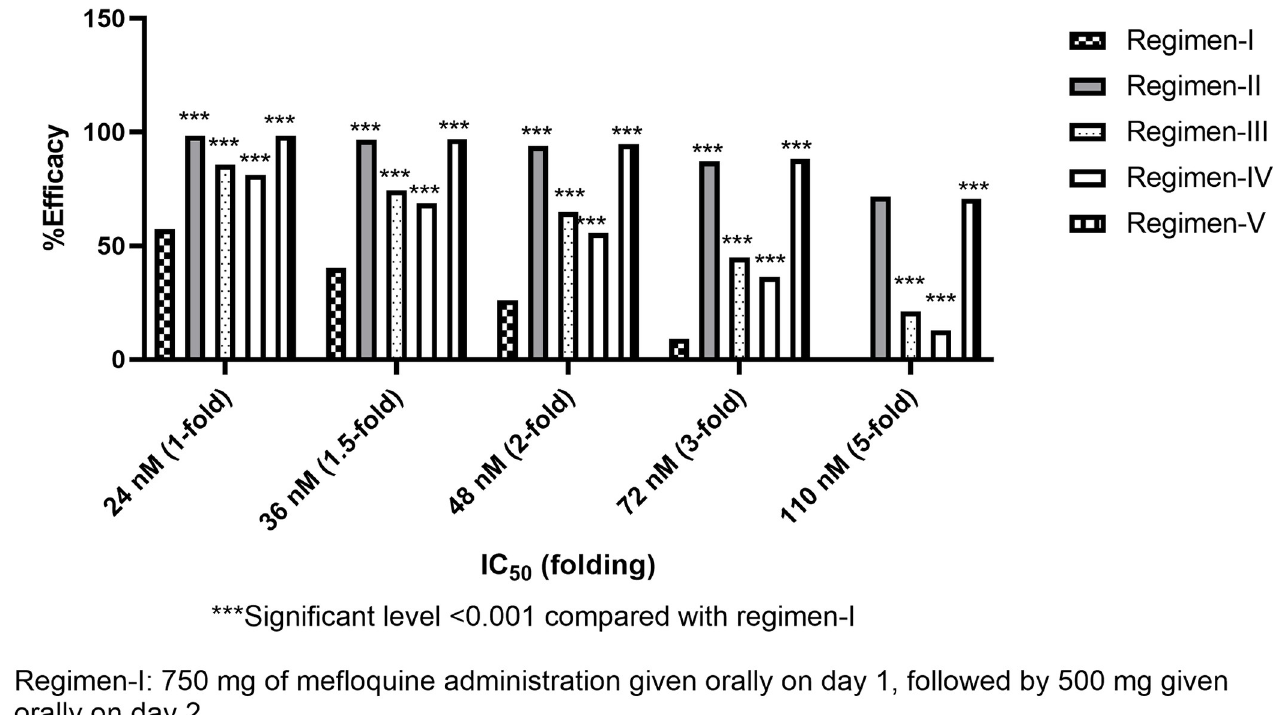
Fig 2. Comparisons of treatment efficacy of different proposed regimens and IC50 values with 100% of adherence in patients with resistant mefloquine.